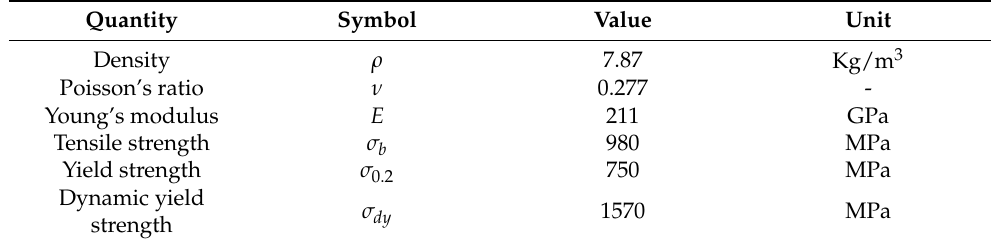
Table 1. Mechanical properties of 40Cr alloy steel.